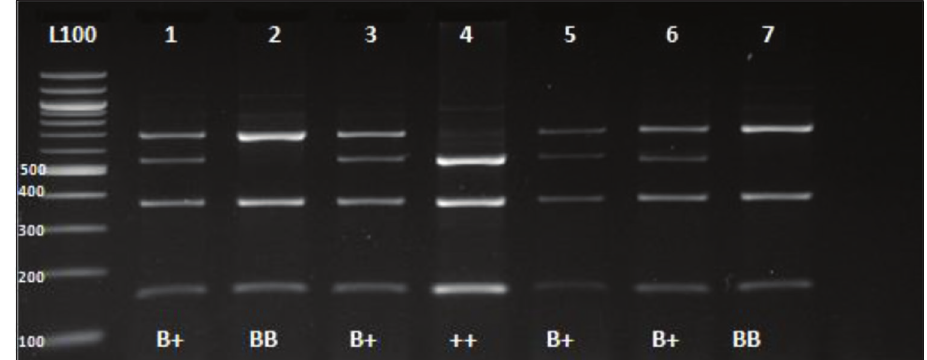
Figure-8: Agarose gel electrophoresis (2%) of the digested product of PRL gene at intron 2 by Hae III restriction enzyme. Lane L: DNA marker 100 bp, Lane 1, 3, 5, and 6 heterozygous genotype. Lane 2 and 7 mutant type. Lane 4: Wild type genotype. Table-3: Allele and genotype frequencies of single and multiple litter ewes of the ovine BMPR-IB , BMP15 ( FecX B , FecX G , FecX H , and FecX I ), GDF9 (G1-G8), and PRL genes in the experimental population.